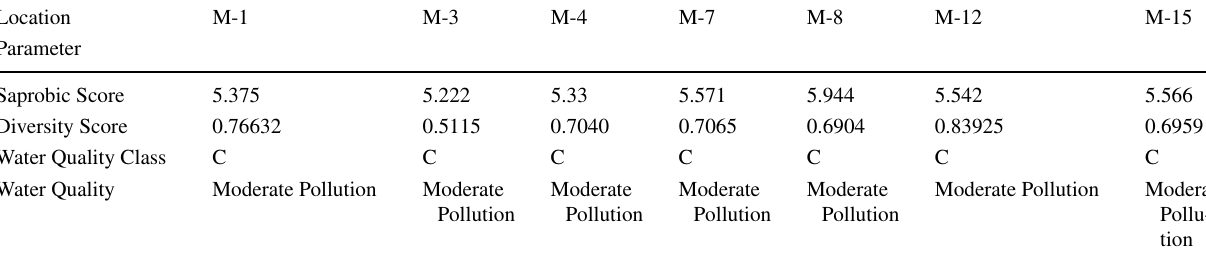
Table 3 Water Quality Class of Mahisagar River based on BWQC